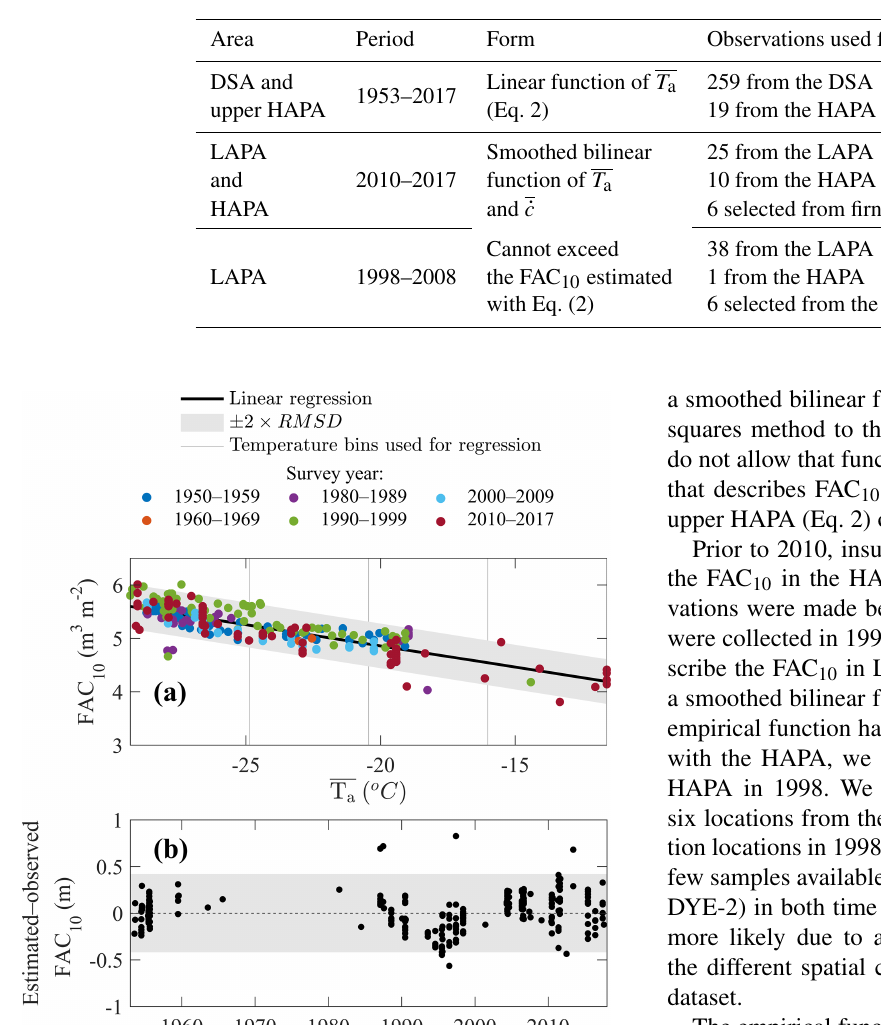
Table 2. Overview of the empirical functions fitted to FAC 10 observations in each region of the firn area.